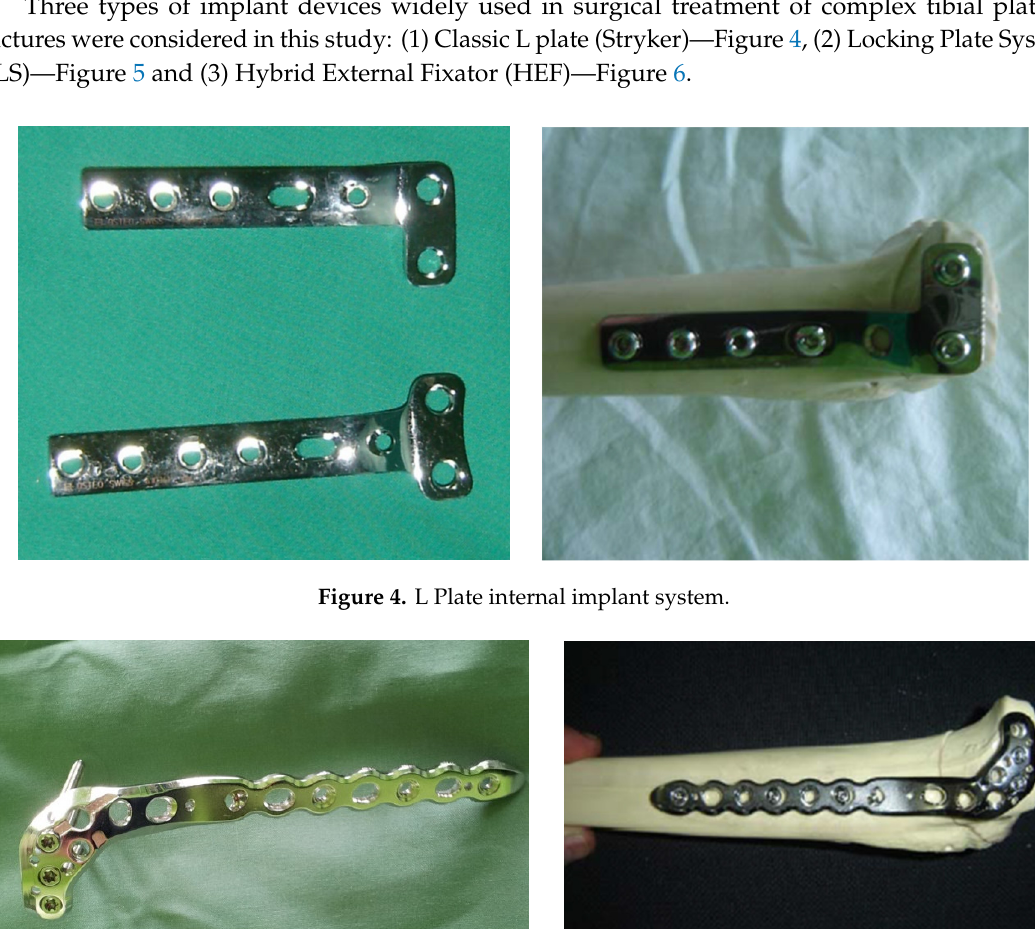
Figure 3. Artificial bone Synbone 1110.